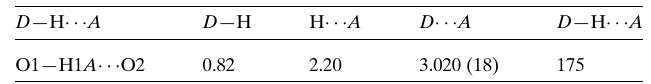
Table 1 Hydrogen-bond geometry (A˚ , (cid:5)